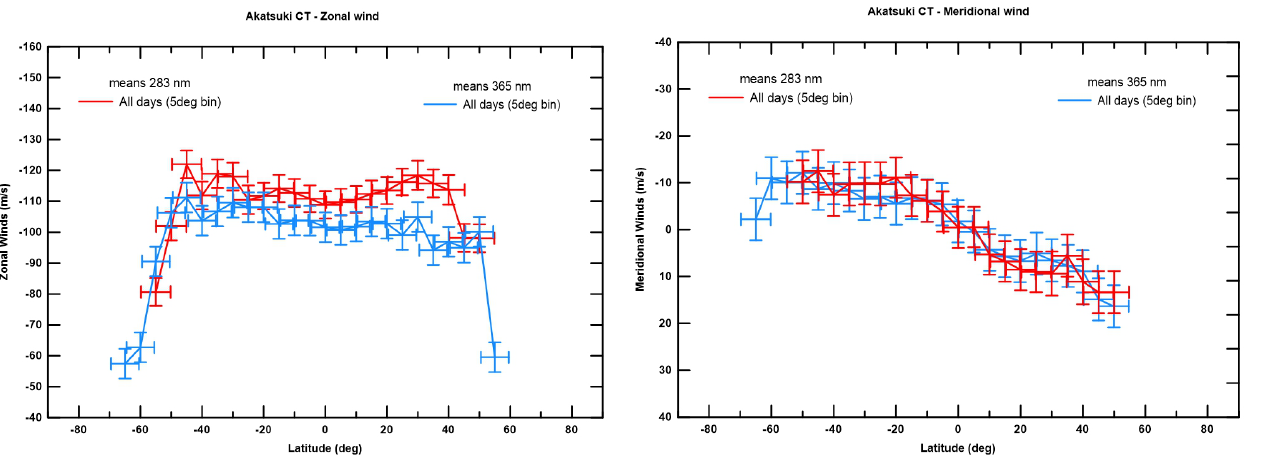
Figure 5. (Left panel) Comparison between the mean zonal wind latitudinal profiles retrieved from Akatsuki/UVI 283 nm filter (red colour in the figure) obtained in the framework of this present work and the one retrieved from the 365 nm UVI filter (blue colour in the figure) produced in the context of Gonçalves et al. [7]. (Right panel) The same as in the left panel, but in this case regarding the meridional wind’s latitudinal